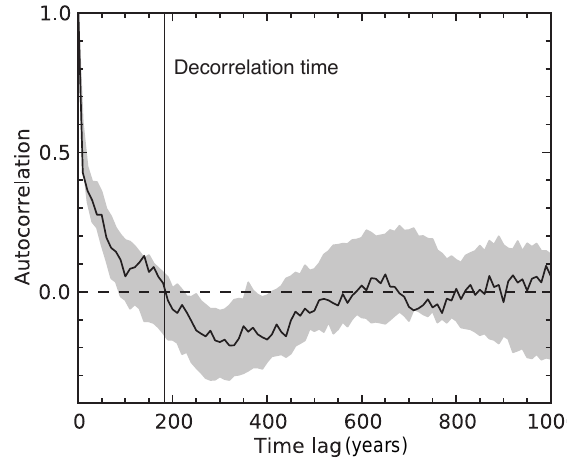
Figure 5. Auto-correlation function (ACF) for the Dongge resid- ual oxygen isotope record (black solid line) computed using the Gaussian kernel estimator by Rehfeld et al. (2011) and Rehfeld and Kurths (2014) after subtracting millennial-scale trends by means of a sliding-window detrending with a bandwidth of 1000 years. The effect of dating uncertainties is illustrated by the full spread of auto- correlation at each time delay obtained from the regularly sampled Dongge COPRA ensemble (Sect. 2.2) using a standard ACF esti- mator (grey shading, Brockwell and Davis, 2006). The decorrela- tion time inferred using the Gaussian kernel estimator is indicated by a vertical